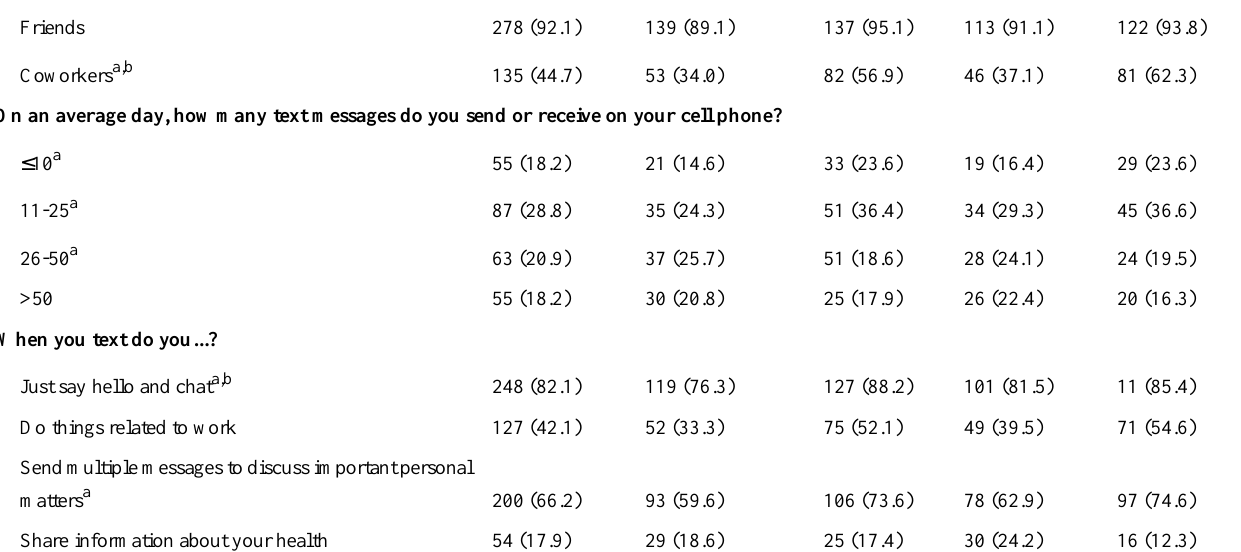
Household income (US